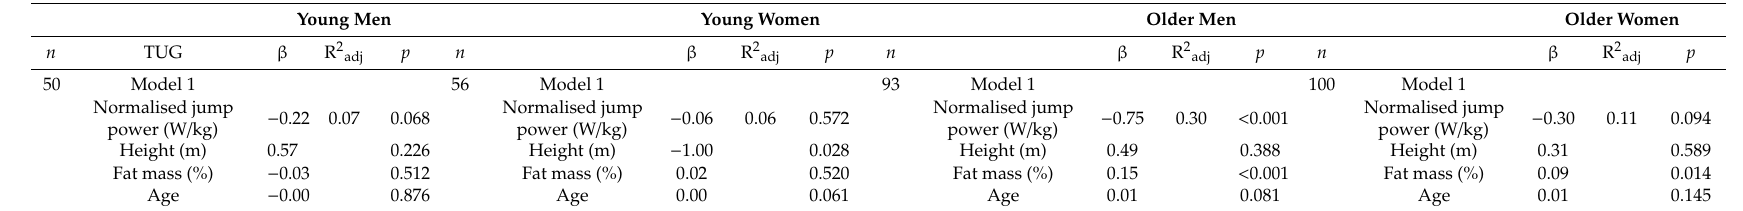
Table 4. Explanatory variables - multivariate regression models stratified by age and sex, with the timed up-and-go test as the dependent variable and body composition and physiological variables as independent